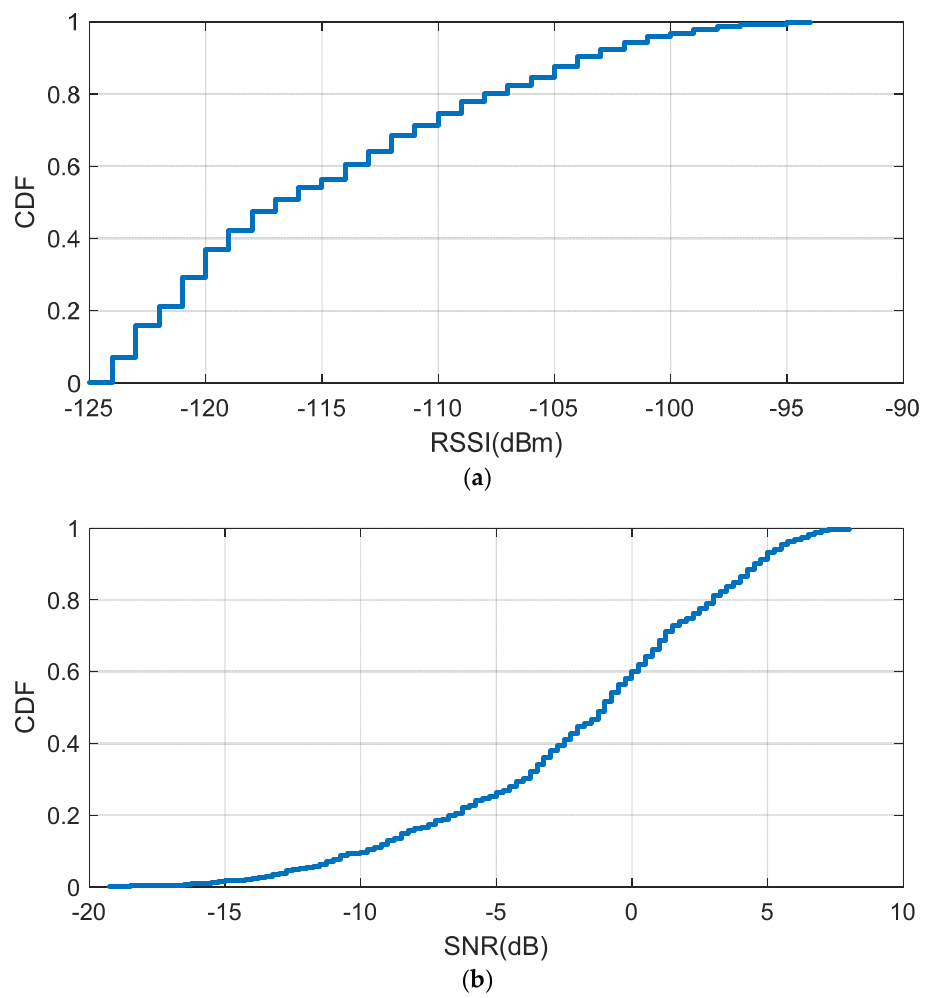
Figure 21. Complementary distribution function of the measured RSSI ( a ) and SNR (signal to noise ratio) ( b ) with the backscatter immersed in the vessel for a transmitter located 80 cm from the vessel.